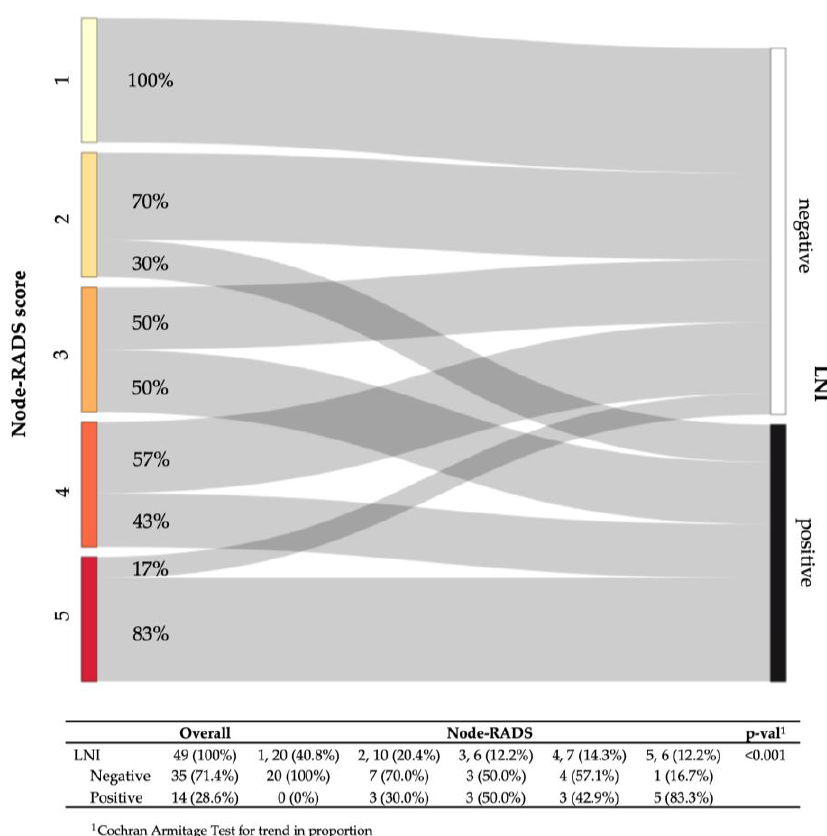
(Node-RADS, age, cT and CIS) exhibited a higher accuracy than a model without Node- RADS, both at the patient (C-index: 0.94 vs. 0.86, respectively) and lymph node levels (C- index: 0.94 vs. 0.81, respectively). Additionally, an LOESS analysis depicted an increase in Figure 2. Sankey diagram depicting the lymph-node invasion (LNI) rates at the final pathologic Figure 2. Sankey diagram depicting the lymph-node invasion (LNI) rates at the final pathologic the LNI risk relative to the increasing Node-RADS score (Figure 3). examination, according to the preoperative Node-Rads score at the patient-level. examination, according to the preoperative Node-Rads score at the patient-level.